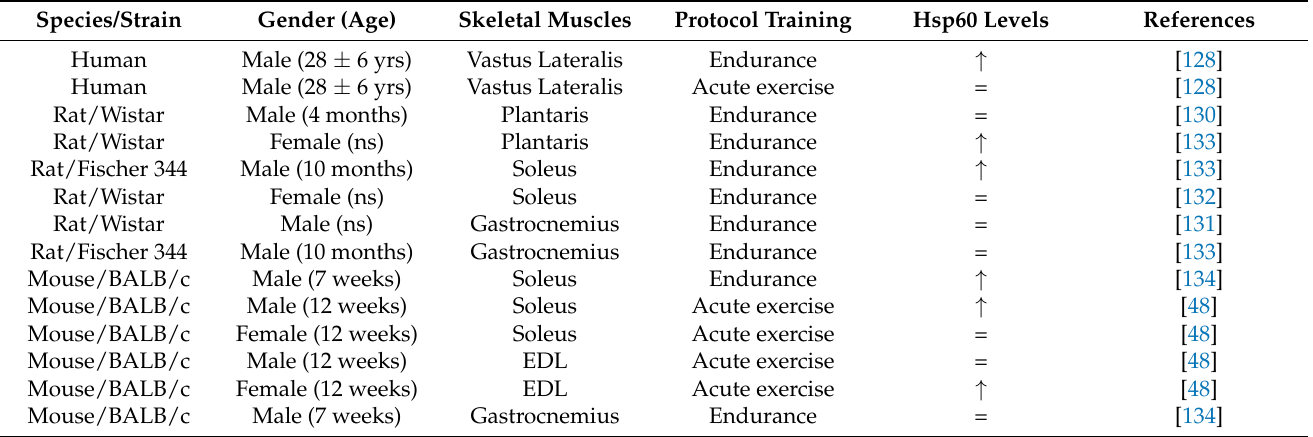
Table 2. Hsp60 expression levels in different skeletal muscles after physical